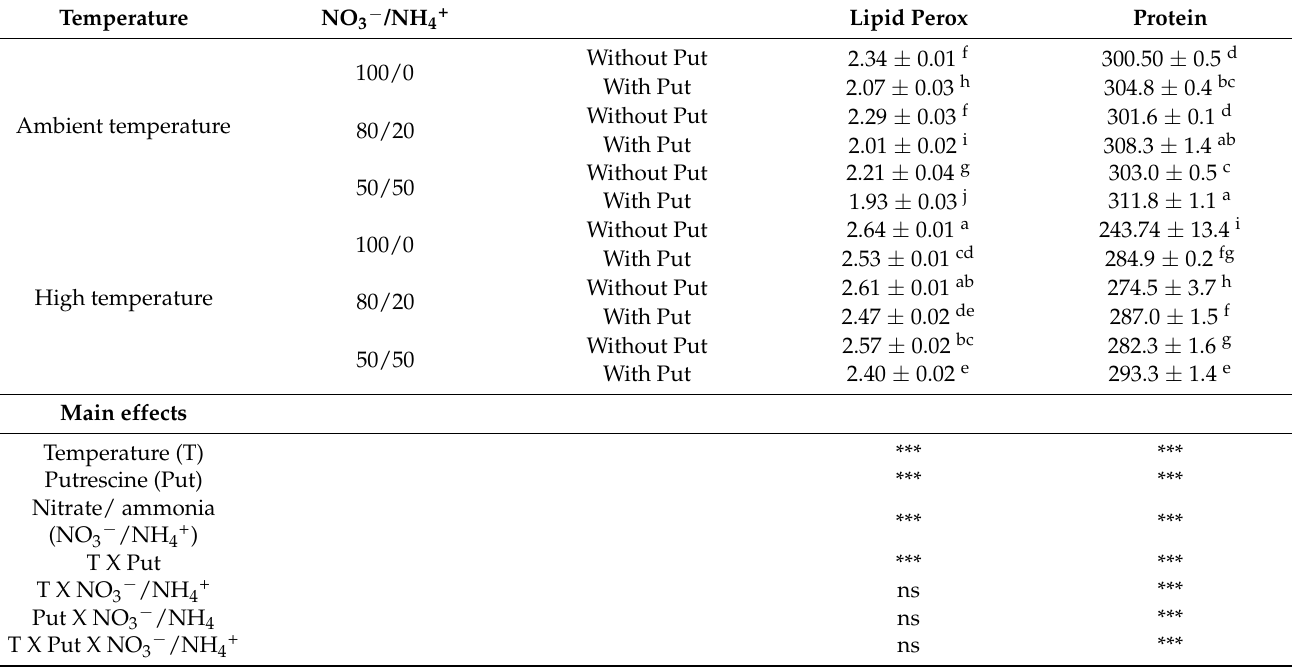
Table 3. Effect of foliar application of putrescine on lipid peroxidation (TBARS µ mol g − 1 FW) and proteins (g kg − 1 DW) in younger leaves of the cauliflower cv. Moonshine at different ration of NO 3 − /NH 4+ and temperatures.